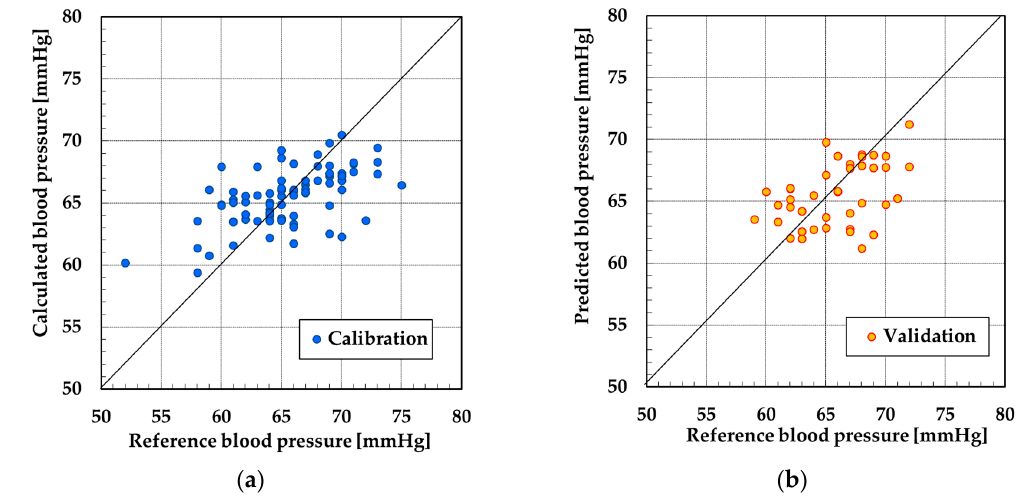
Figure 10. Result at diastolic blood pressure (DBP) by PLSR of subject A: ( a ) calibration and ( b ) validation.